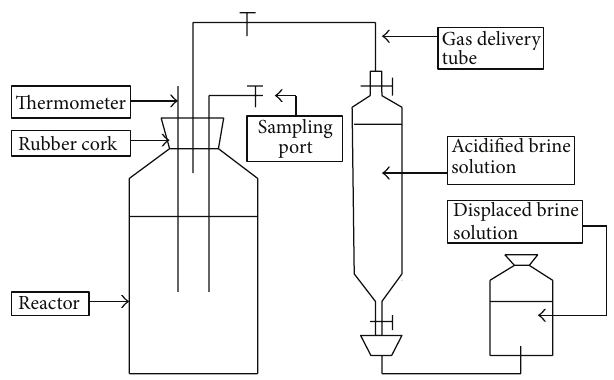
Figure 3: Schematic diagram of experimental